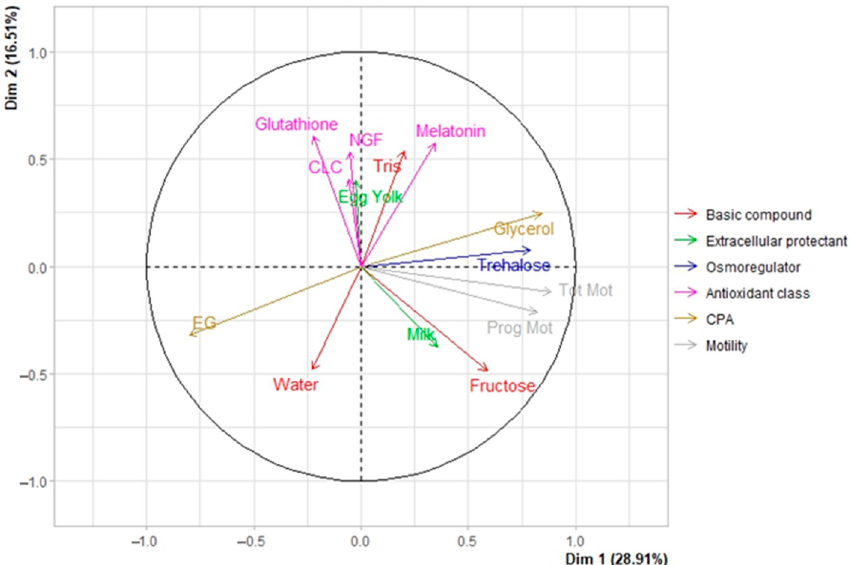
Figure 6. Biplot of a basic compound, extracellular protectant, CPA and osmoregulator, antioxidant class, and motility parameters on dimensions 1 and 2.